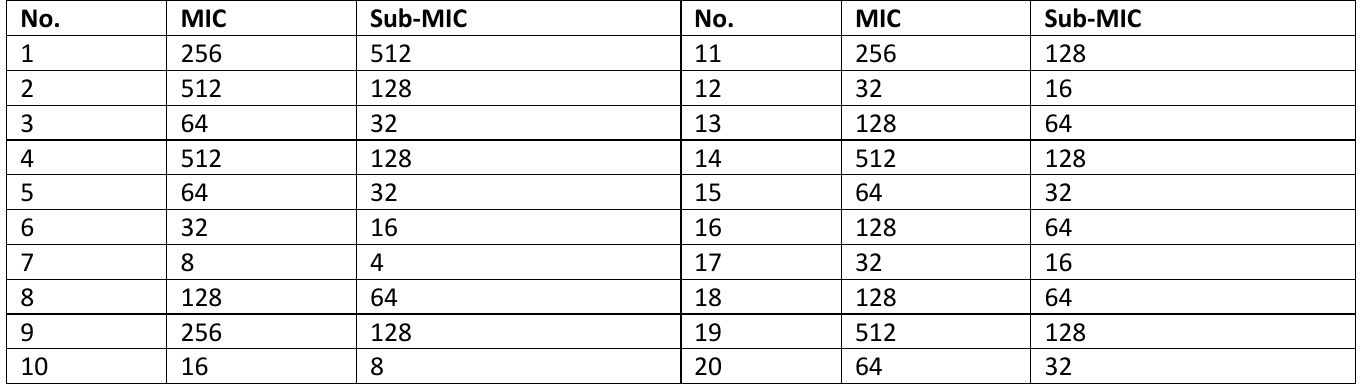
Table 2. MIC and sub-MIC of Amoxicillin/clavulanic for Staphylococcus aureus.